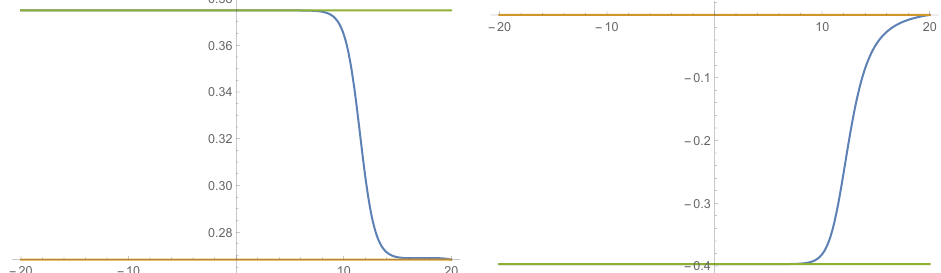
Figure 6. The profiles of ϕ ( r ) ( left ) and χ ( r ) ( right ), plotted against r the ones in the non-SUSY-G 2 vacuum as r → − ∞ , while they approach those in the non-SUSY SO ( 7 ) as r → + ∞